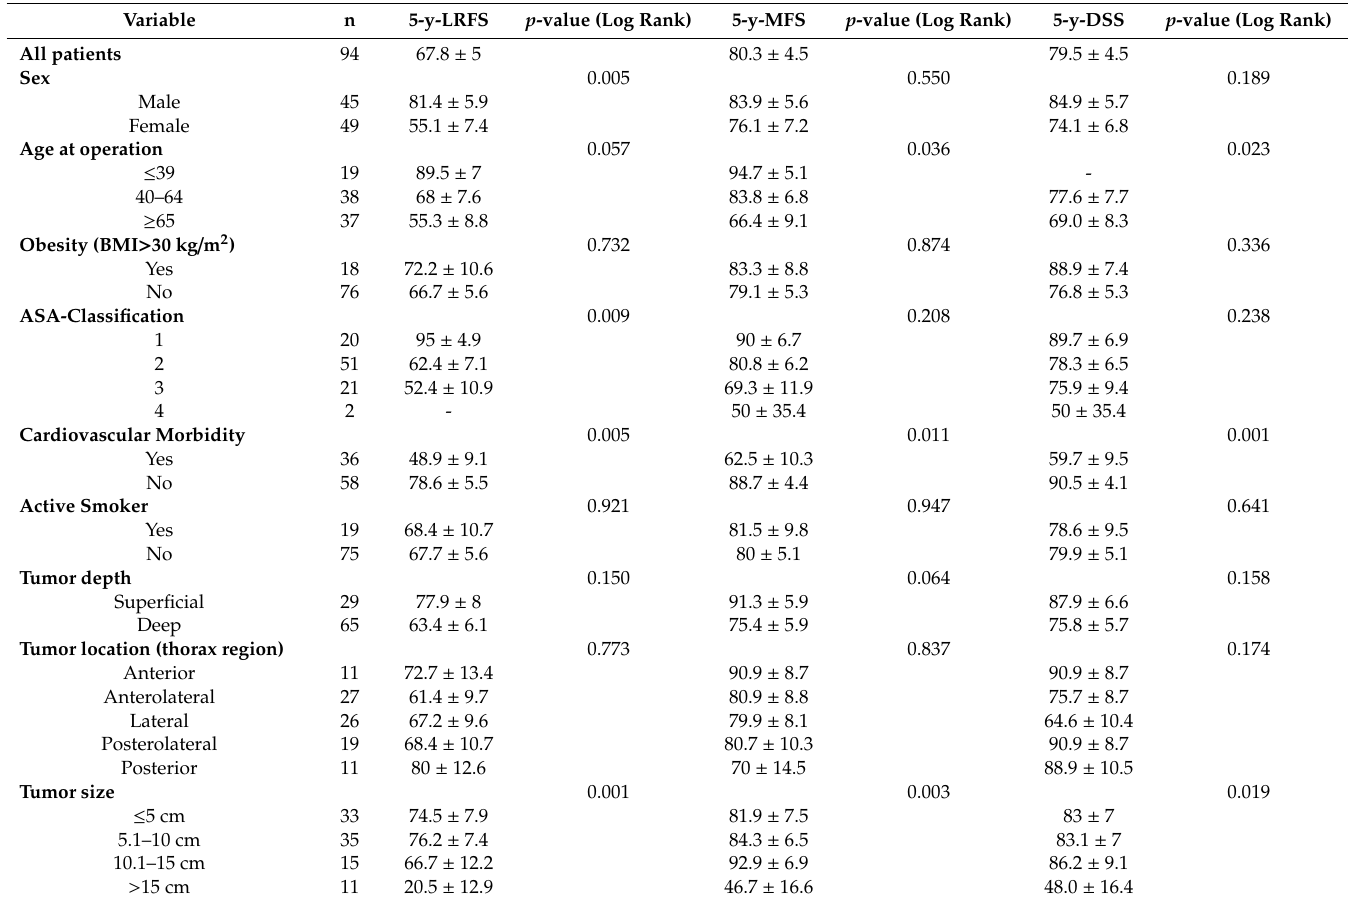
Table 3. Univariate analysis of factors associated with 5-y LRFS, MFS, and